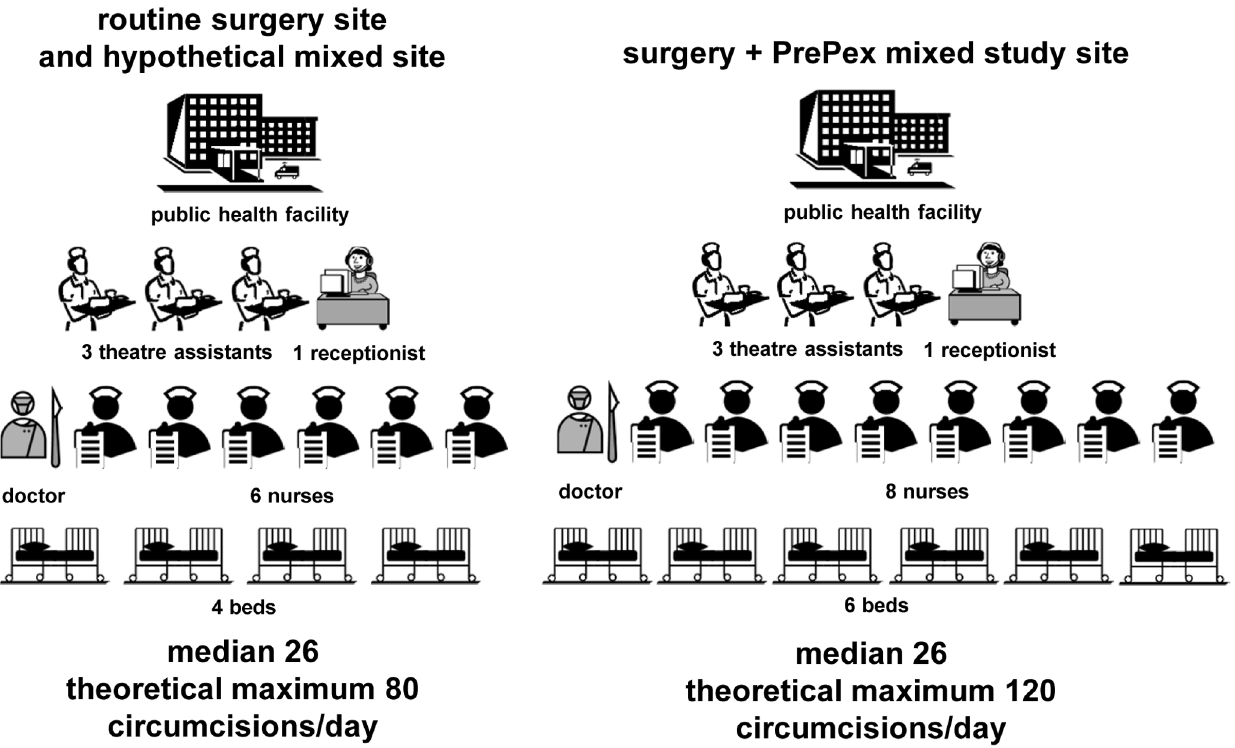
Figure 1. Key characteristics of the different implementation models. The routine surgery site and the hypothetical mixed site employed 1 medical doctor, 6 nurses, 3 theatre assistants, and 1 receptionist in a 4-bed facility, and the mixed study site employed 1 medical doctor, 8 nurses, 3 theatre assistants, and 1 receptionist in a 6-bed facility.